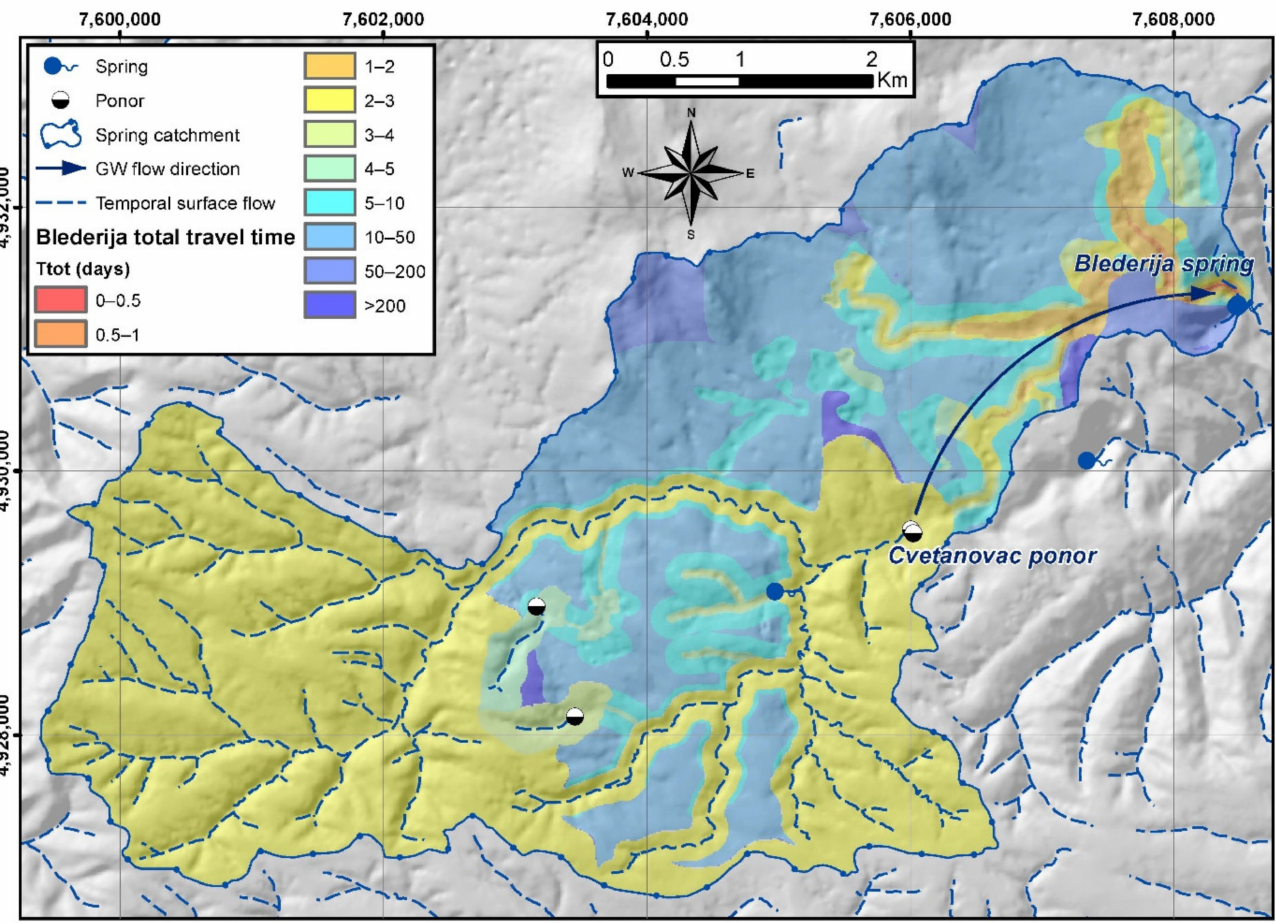
Figure 9. Map of total water travel time to the Blederija